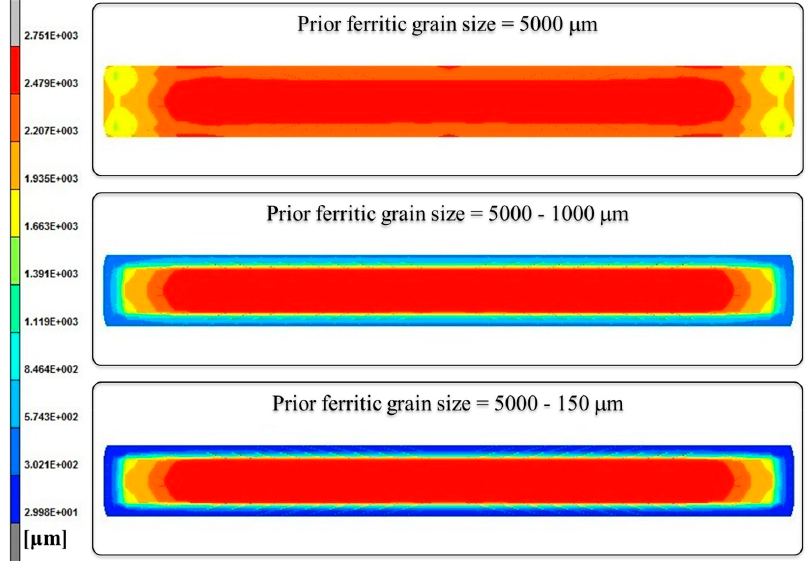
Figure 11. Effect of different PFGS on the ferrite grain size after the second roughing pass.